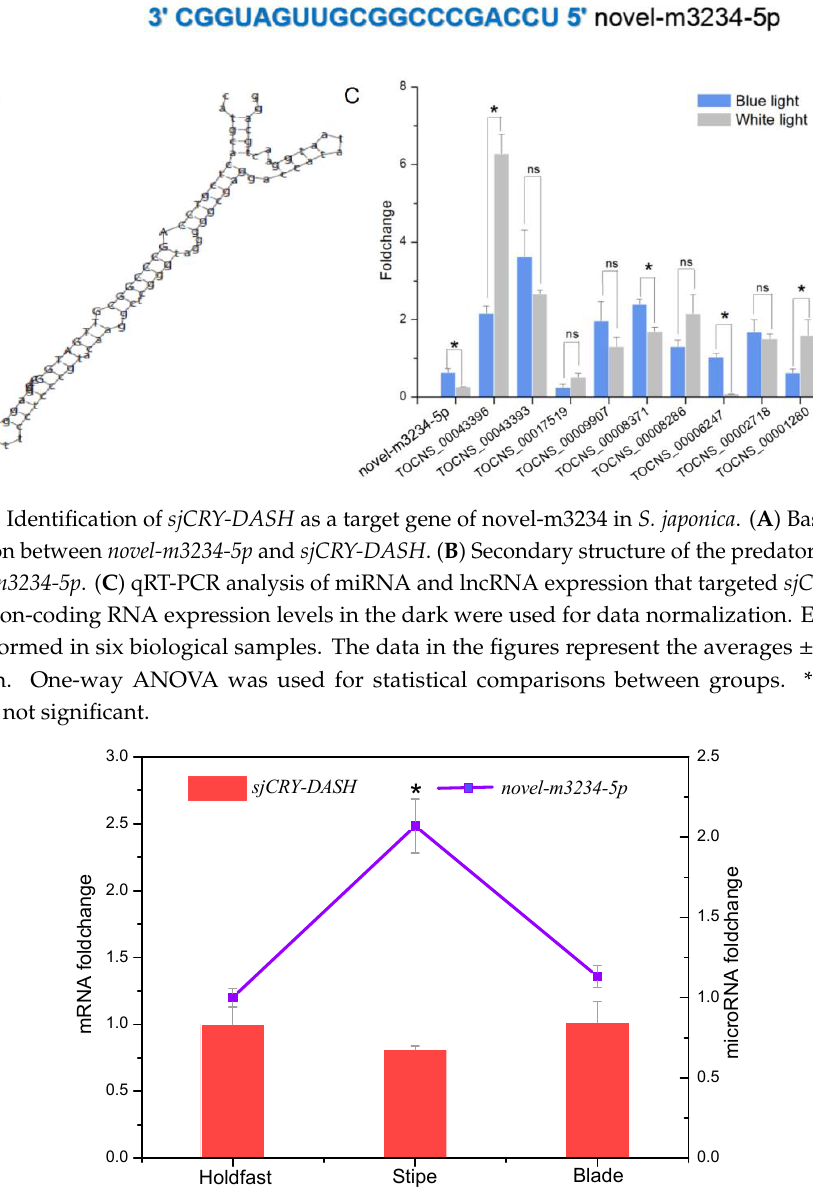
Figure 7. Tissue-specific transcription expression of novel-m3234-5p (point) and sjCRY-DASH (bar) in S. japonica. Each value was performed in six biological samples. The data in the figures represent the averages ± standard deviation. * p < 0.05 based on one-way ANOVA.